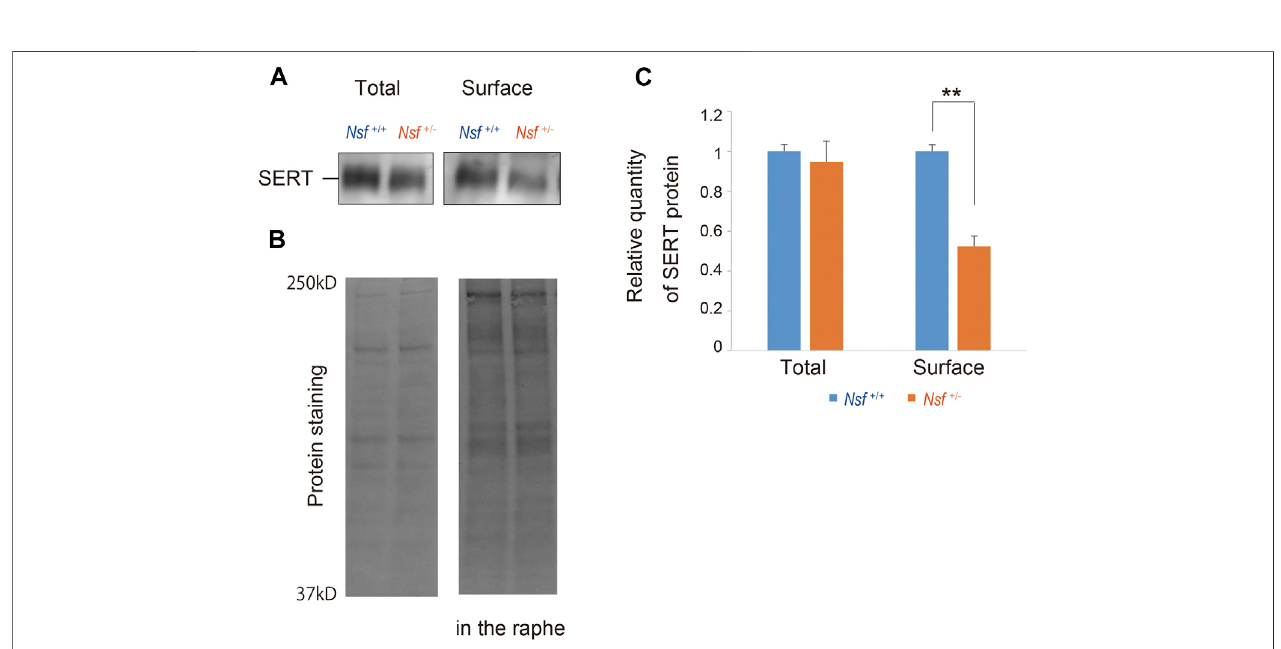
FIGURE5| Decreaseinserotonin transporter(SERT) expression atthemembrane surfacein Nsf +/ − mice. (A) Totaland biotinylatedmembraneprotein levelsinthe rapheofmouseofeachgenotypewereanalyzedbyimmunoblottingusingananti-SERTantibody. (B) Stain-FreegelswereactivatedbyUVexposureandimagedusinga ChemiDocTMMPimagerasprotein loadingcontrol. (C) Relativeband densities ofSERT werequanti fi edusing scanningdensitometryand normalized toprotein loading control Results are expressed as a ratio of Nsf +/+ mice expression, resulting in a Nsf +/+ mice ratio of 1. ( n (cid:1) 4 for each genotype, mean ± SEM. Student ’ s t-test, ** p <